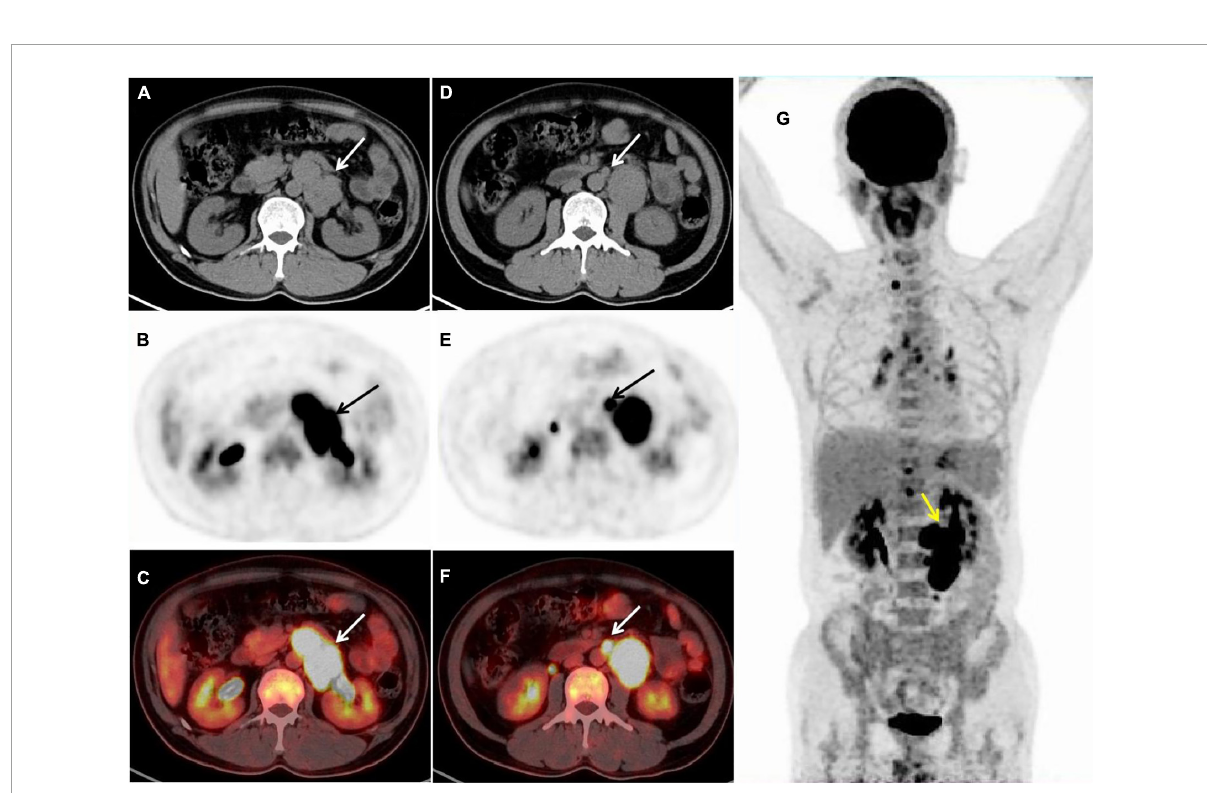
FIGURE2 Whole body 18 F-fludeoxyglucose positron emission tomography/computed tomography ( 18 F-FDG PET/CT) as a screen for primary malignancy. An axial computed tomography (CT) image demonstrating a retroperitoneal soft tissue density mass at the level of the left hilum is shown in (A) (arrow). PET (B) , fused PET/CT images (C) , and a maximum intensity projection (MIP) image (G) revealing significantly increased FDG activity in the left retroperitoneal mass (arrow) are shown. An axial CT image (D) reveals the presence of a lymph node adjacent to the mass (arrow), while PET (E) and fused (F) images show significant uptake of FDG by the retroperitoneal lymph